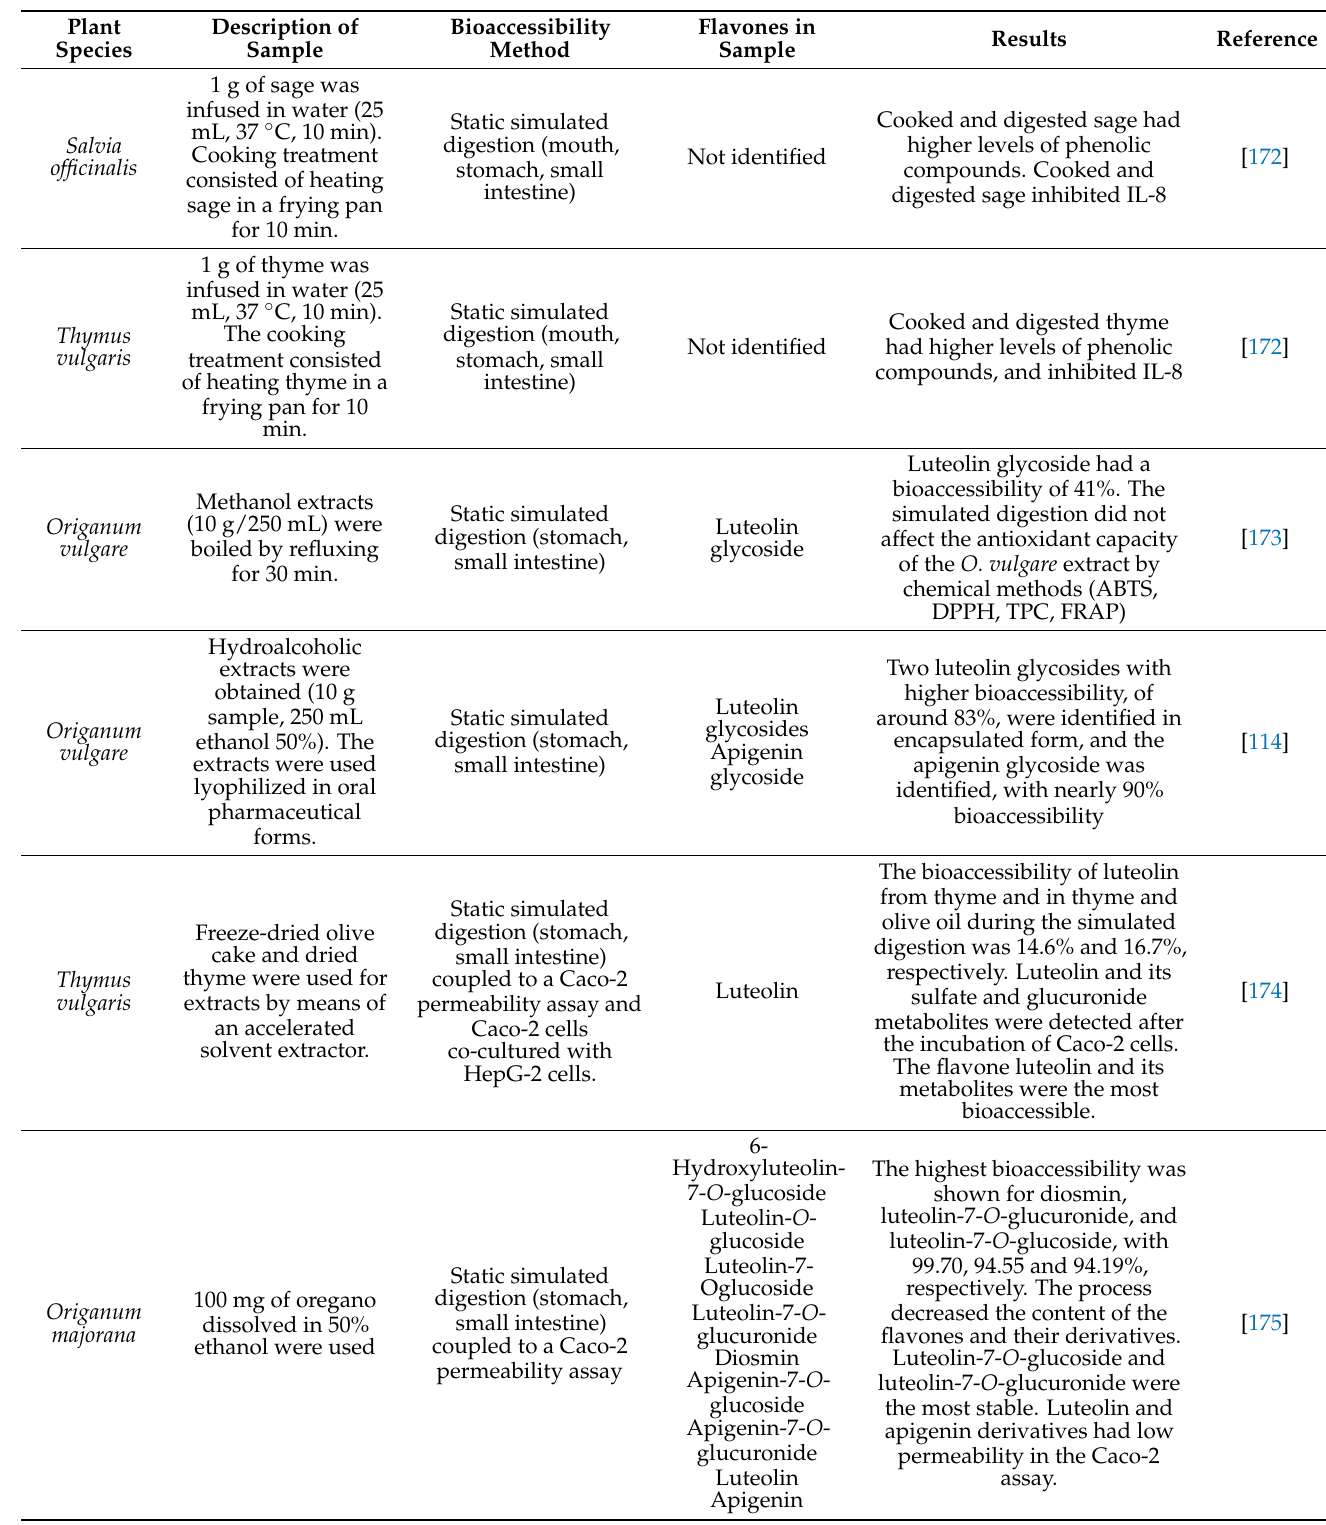
Table 5. Bioaccessibility and bioavailability studies of flavones from Lamiaceae